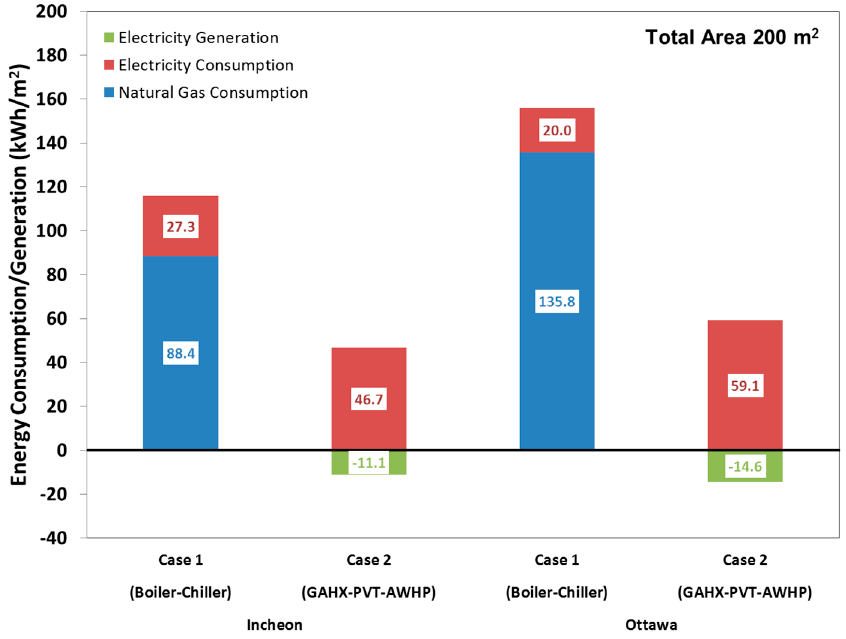
Figure 4. Annual electricity and natural gas energy consumption/production intensity.